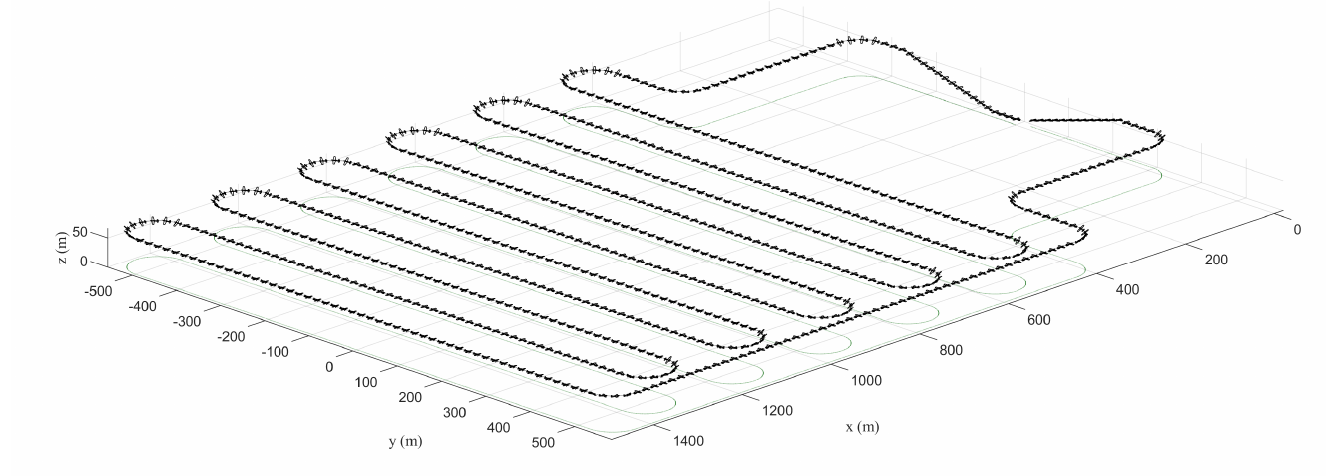
Figure 18. Trajectory plot of the simulated 1 km by 1 km field coverage flight mission (the aircraft is plotted 8 × scale every 1.0